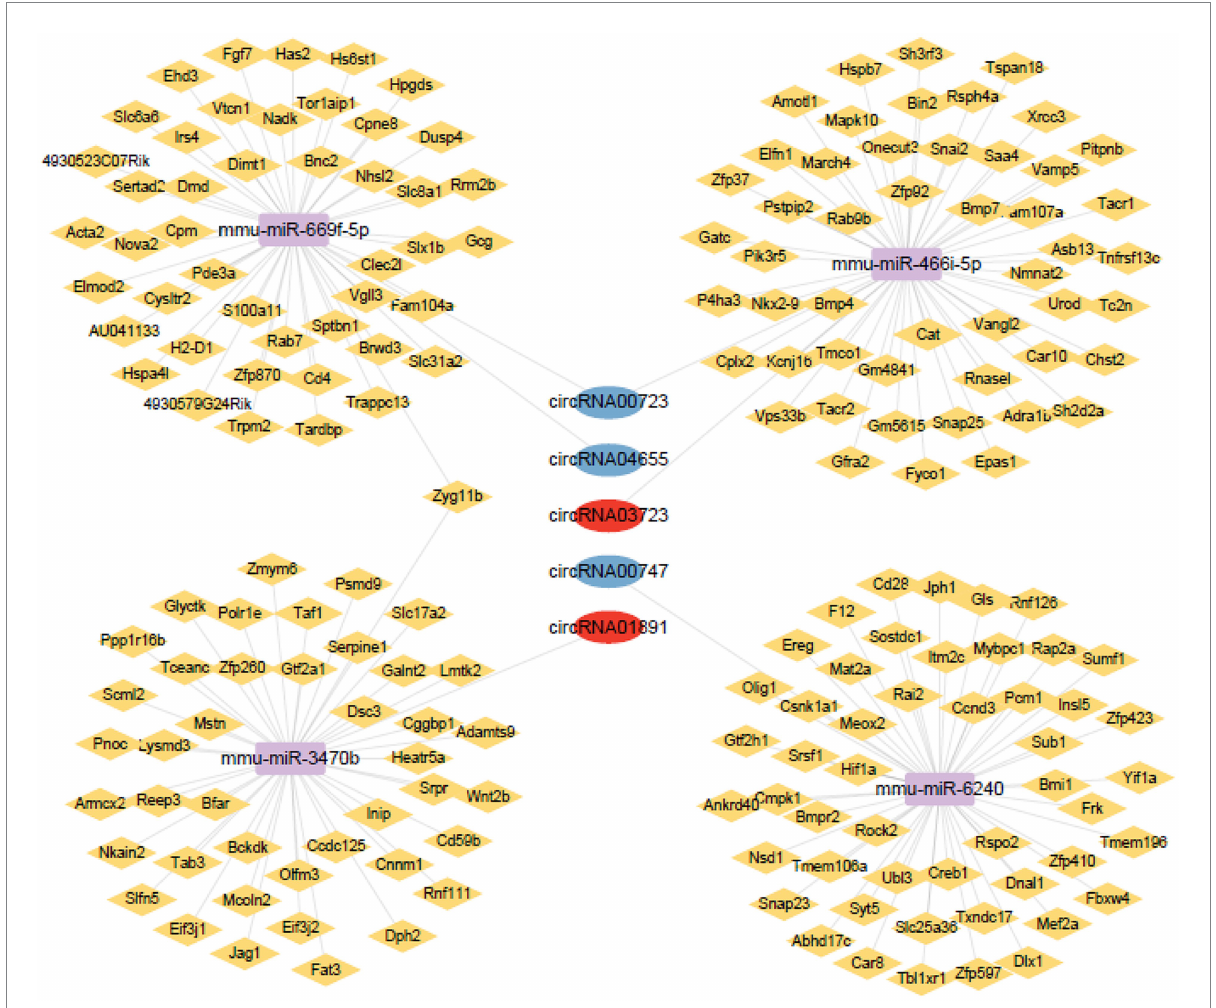
FIGURE 7 Network of circRNAs-miRNAs-mRNAs. Upregulated circRNAs are shown using red circles, downregulated circRNAs are shown using blue circles, potential miRNAs are shown using purple squares, and potential mRNAs are shown using yellow